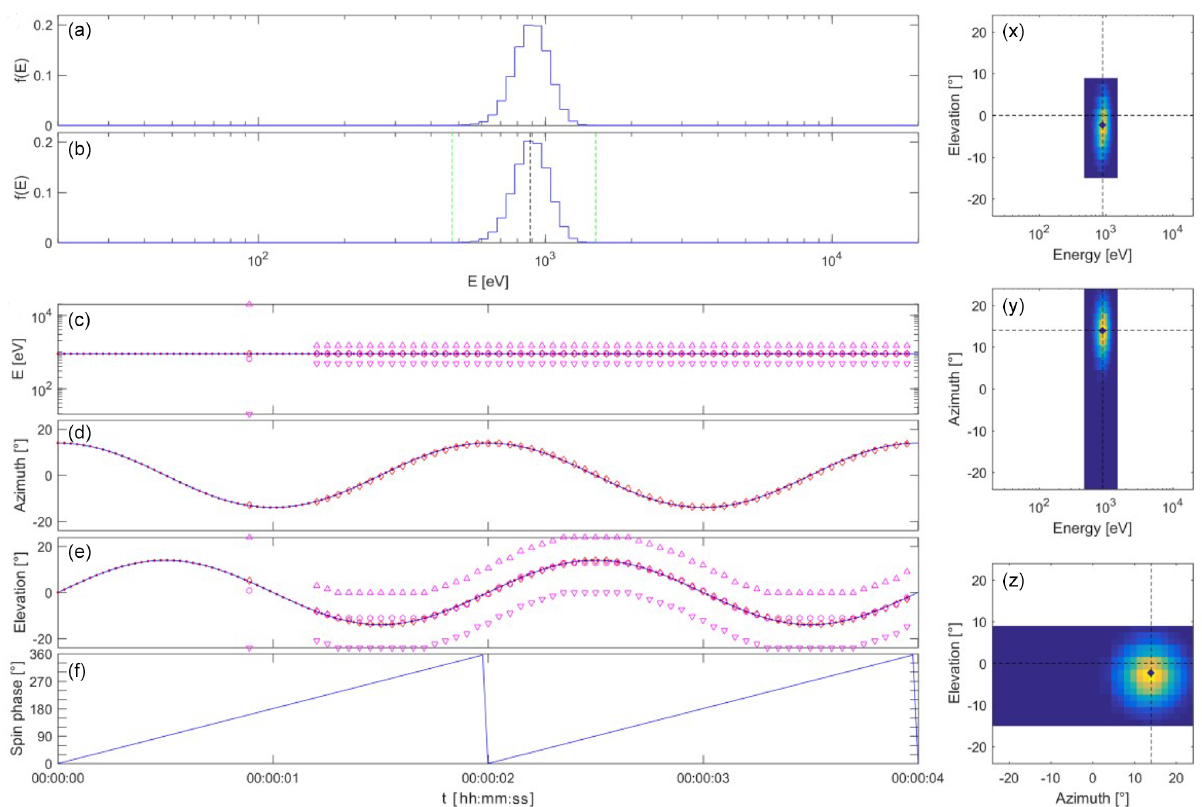
Figure 1. Plasma spectrometer measurements of a constant Maxwellian solar wind beam on a rapidly spinning spacecraft using internal energy and elevation beam tracking. From (a) – (f) and (x) – (z) : (a) the energy spectrum of the Maxwellian solar wind; (b) the energy spectrum as acquired by the plasma spectrometer at t = 3 . 95s with the vertical black and green dashed lines indicating the centre and the bounds of the sampled energy range; (c) the energy as a function of time, where the horizontal blue line represents the true solar wind value, the small red dots are the Faraday cup measurements every 30ms (not used with internal beam tracking), the magenta circles and triangles indicate the centre and the bounds of the sampled energy range, and the red diamonds give the mean energy as determined by the plasma spectrometer; (d) the azimuth (same format, no beam tracking for azimuth); (e) the elevation (same format); and the (f) spin phase. The panels at the right hand side show (x) the energy–elevation, (y) energy–azimuth, and (z) azimuth–elevation projections of the VDF at t = 3 . 95s. See the main text for more